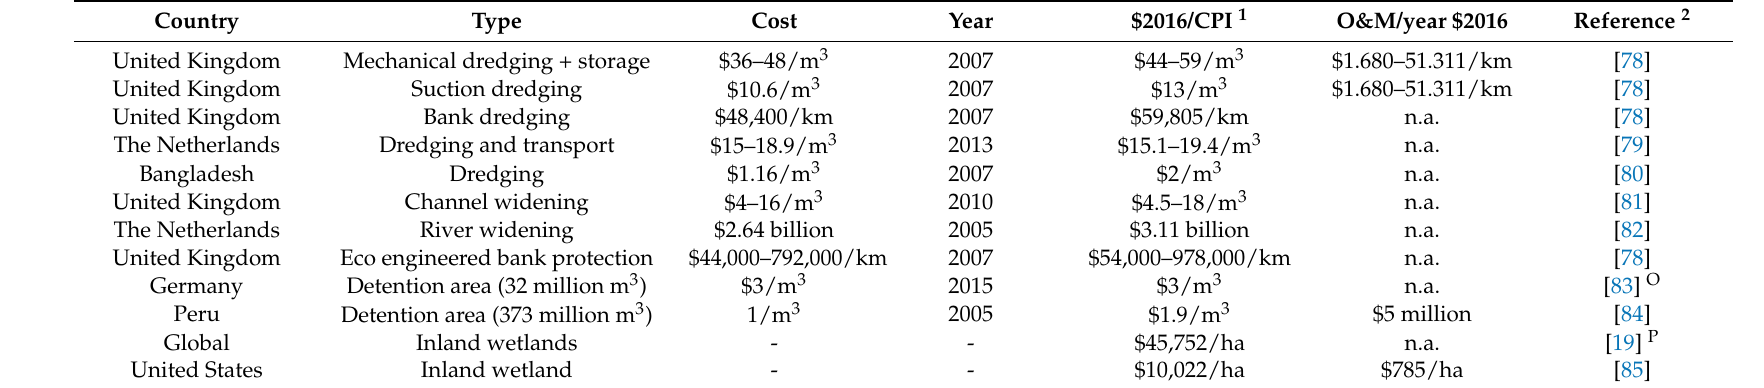
Table 7. Costs for channel management, and nature-based solutions for riverine